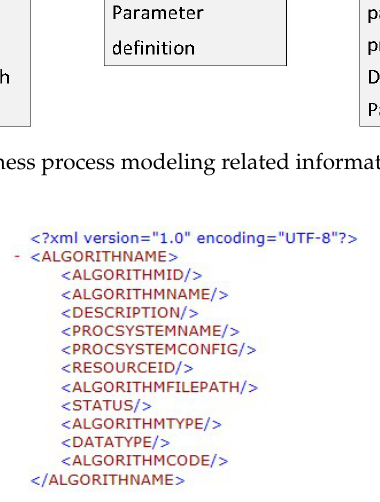
Figure 3. Algorithm parameter